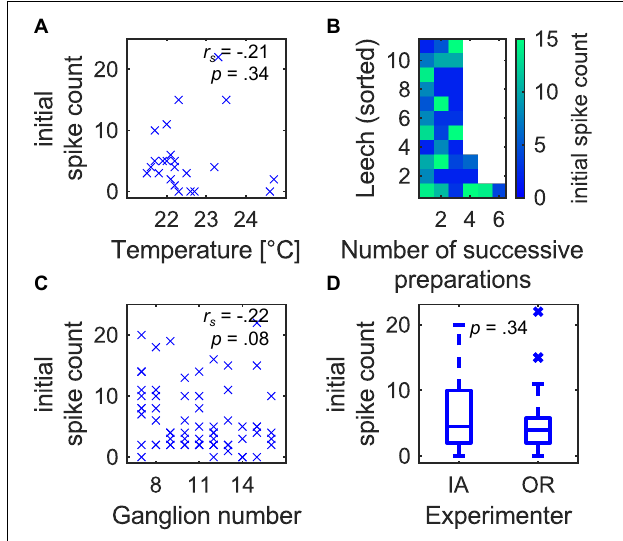
FIGURE 3 | Confounder analysis for the initial spike count in T3 cells. (A) The temperature did not affect the initial spike count systematically. (B) The leech individual, sorted by the number of successive preparations, also did not reveal any obvious patterns in the initial spike count, indicating that the observed variability in the initial spike count was not systematically caused by the leech individual. (C) Neither the position of the midbody ganglion in the nerve cord, (D) nor the experimenter/setup had a significant effect on the initial spike count.